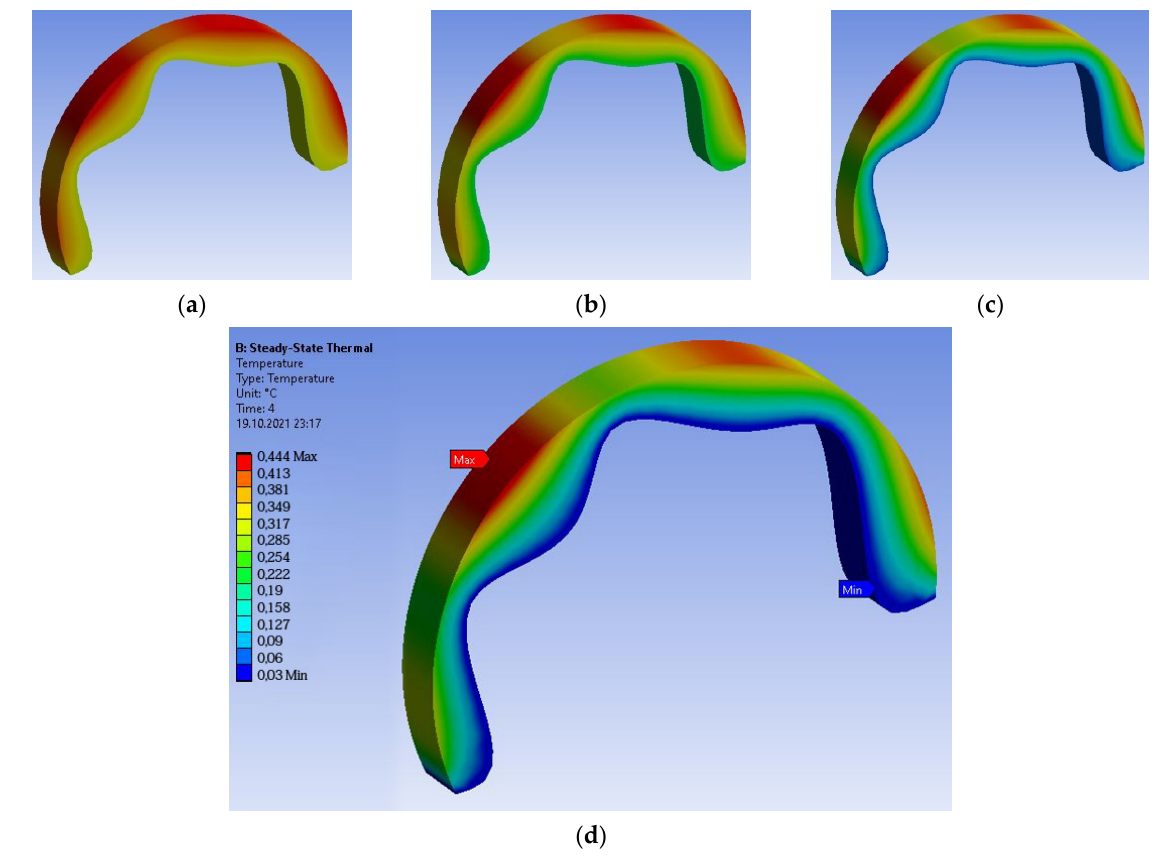
Figure 3. Heat transitions of the model at ( a ) 0.3 s, ( b ) 0.6 s, ( c ) 0.9 s and ( d ) 1 s.